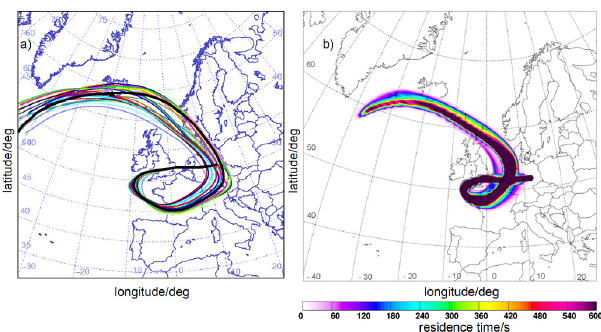
Fig. 8. Backward trajectories starting at 4.2km altitude near Leipzig at 15:10UTC 19 April (Table 3, leg 1). (a) The curves rep- resent an ensemble of 27 backward trajectories, computed with HYSPLIT. (b) Ash mass residence times in grid cell columns of 0.5 ◦ × 0.5 ◦ × 12km along the backward trajectories (back to 18:00UTC 14 April), computed with